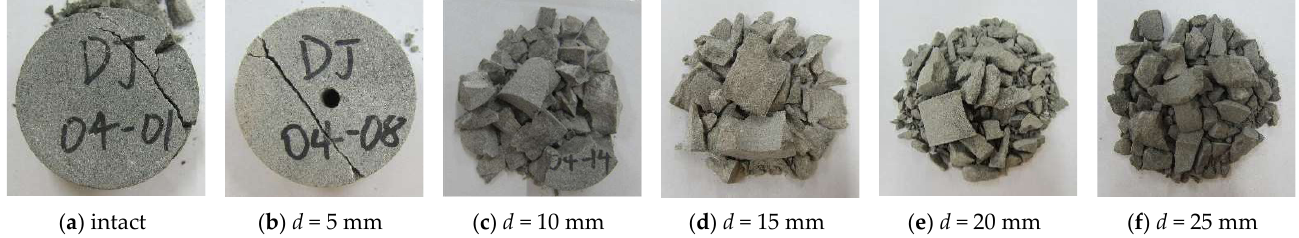
Figure 14. Fracture morphology of specimens with temperature and water coupling.